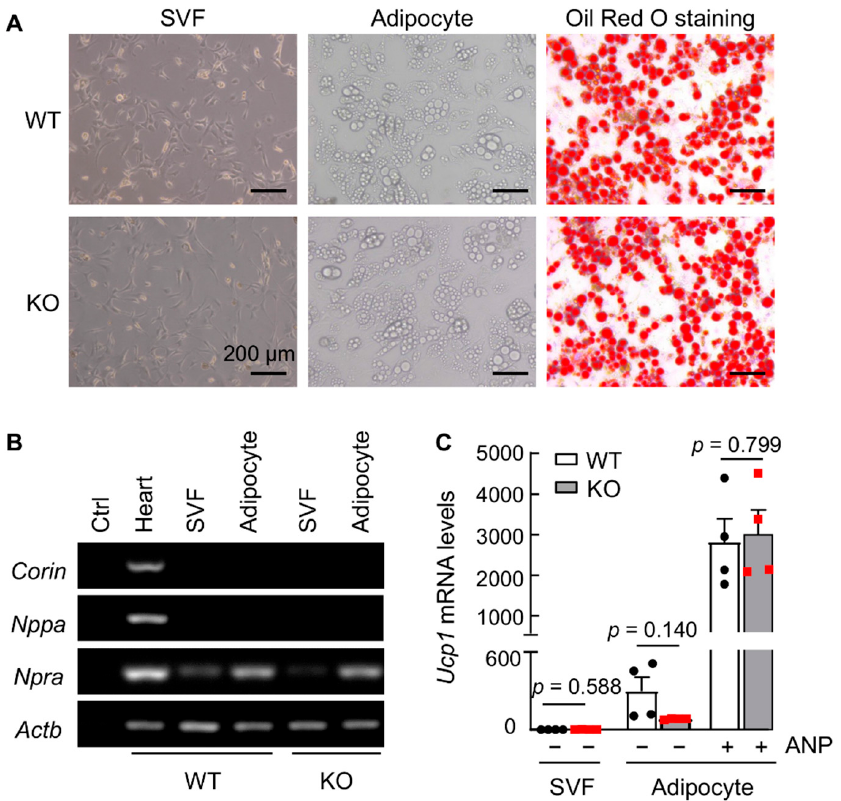
Figure 7. Analysis of differentiated adipocytes from iBAT of WT and corin KO mice. ( A ) Microscopic images of iBAT-derived stromal vascular fraction (SVF) cells before (left) and after (middle) differentiation, and Oil Red O-stained adipocytes after differentiation (right). ( B ) RT-PCR analysis of Corin , Nppa , and Npra mRNA levels in hearts (positive control) and iBAT-derived SVF cells without and with differentiation. Actb , encoding β -actin, was a control. Data are representative of three experi- ments. ( C ) qRT-PCR examination of Ucp1 mRNA levels in iBAT-derived SVF cells and differentiated adipocytes from WT and corin KO mice without ( − ) or with (+) ANP treatment (100 nM) ( n = 4). Data in C are mean ± SEM. p values were determined by Student’s t